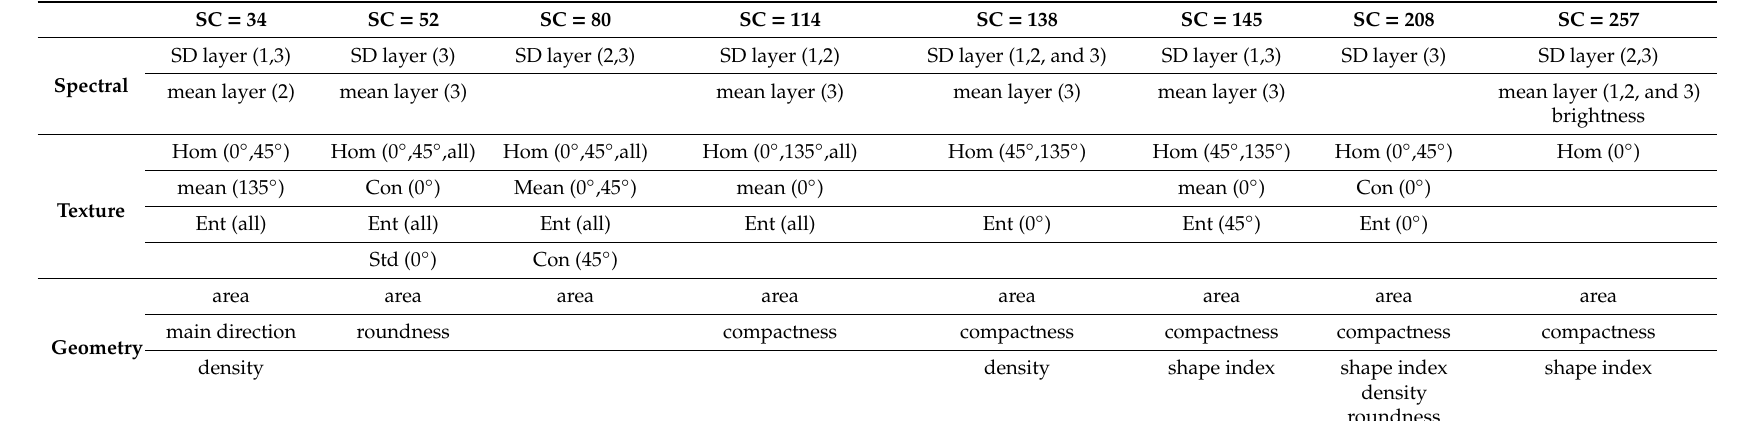
Table 1. Optimization feature space under di ff erent segmentation scales